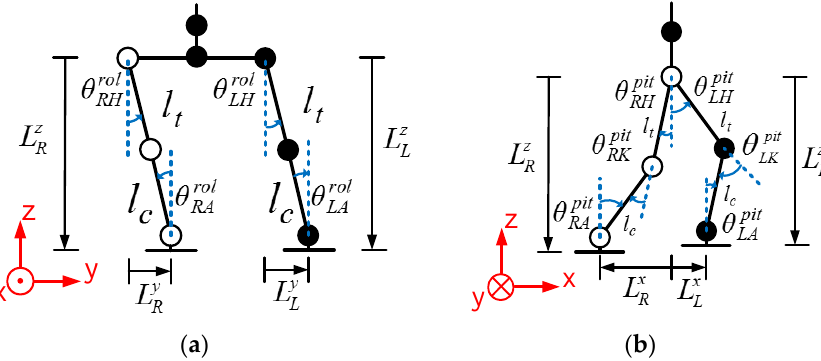
Figure 11. Link coordinate system of the humanoid robot. ( a ) Front view. ( b ) Right side view. Based on the link coordinate system in Figure 11a and the inverse kinematics, θ rol